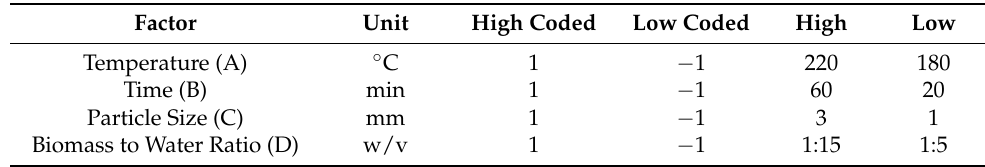
Table 1. The process variables with their levels for synthesis of hydrochar via microwave-induced hydrothermal carbonization (MIHTC).